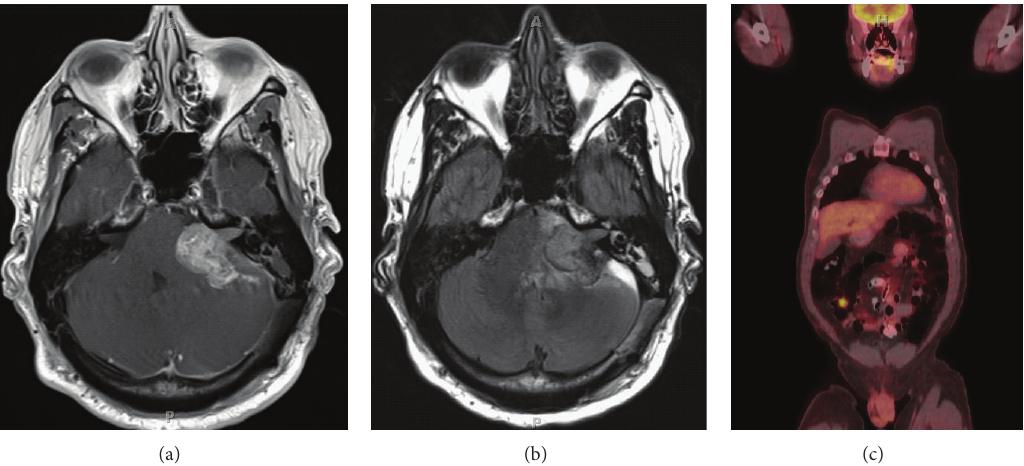
Figure 2: (a) T1-axial MRI with contrast and (b) T2-axial Flair MRI demonstrating enhancing mass in the left cerebellopontine angle 8 weeks later.(c)Post-operativewholebodypositronemissiontomographydemonstratingincreaseduptakeintherightlowerquadrantcorresponding to the small